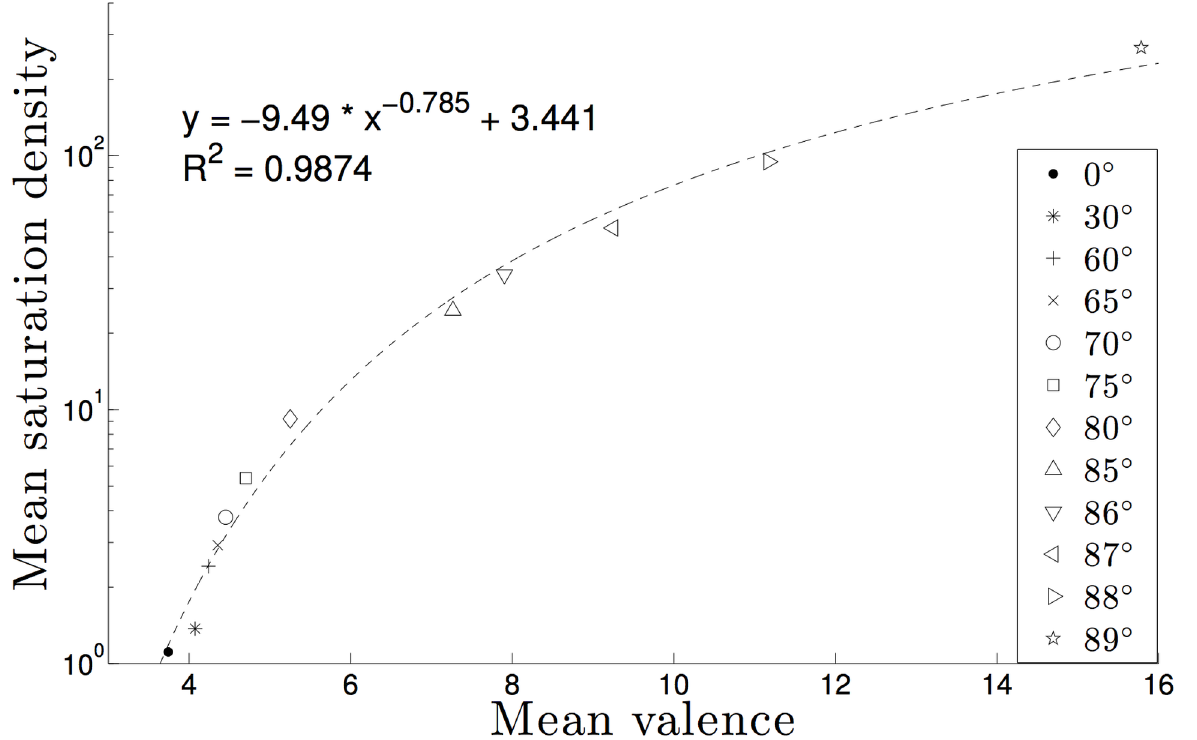
Fig 4. Estimated average saturation density for various restriction angles. Each data point in the figures is based on samples of sample size 1000 and minicircle grids of dimension 1000 × 1000. The 95% standard error bars are less than.0005 in all cases.